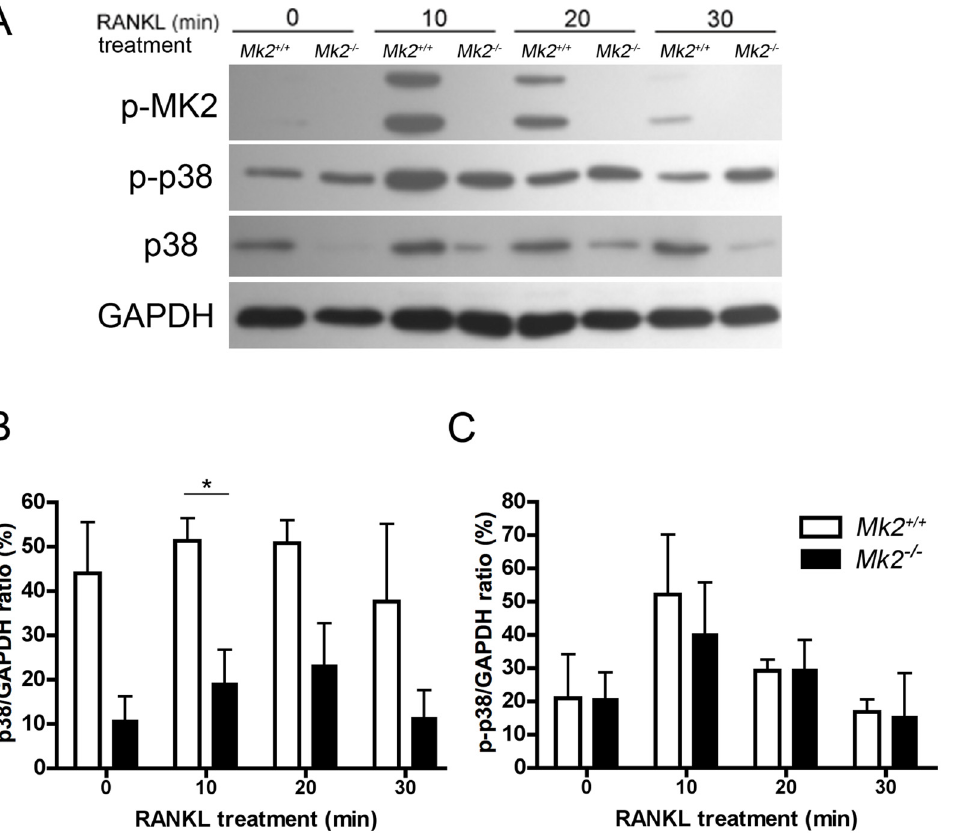
Fig 3. RANKL stimulates MK2 phosphorylation in dOCP lo pre-osteoclasts. (A) Representative western blot of pre-osteoclasts from male mice primed with M-CSF (10 ng/mL) for two days and stimulated with RANKL (100 ng/mL) for the indicated minutes (min). Densiometric analysis of (B) p38 (left) and (C) p-p38 (right) as a percent of GAPDH. Data are expressed as means ± SE compared to Mk2 +/+ controls ( * P (cid:1) 0.05).